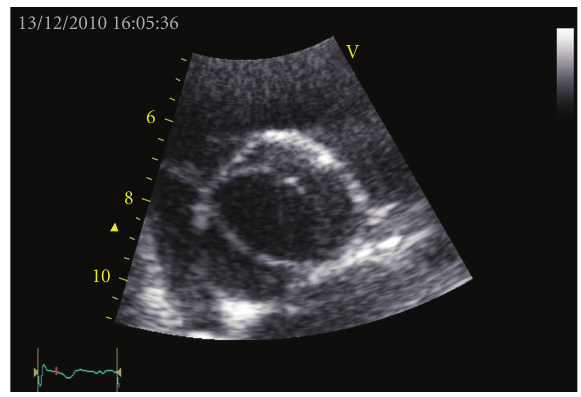
Figure 7: Echocardiographic image of a bicuspid aortic valve.